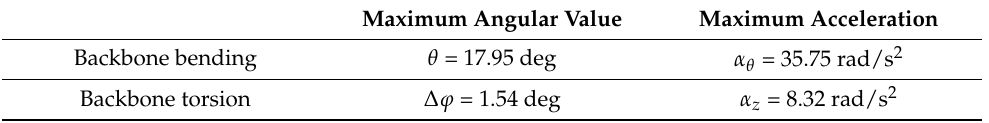
Table 3. Experimental